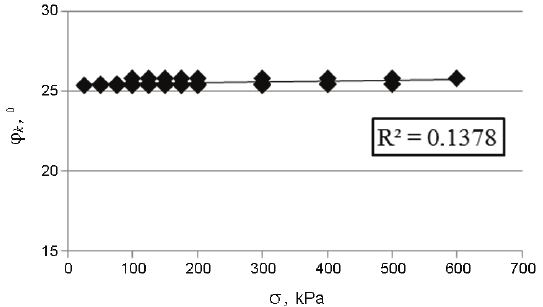
Fig. 12. The angle of internal friction versus vertical stress (results of 12 tests)